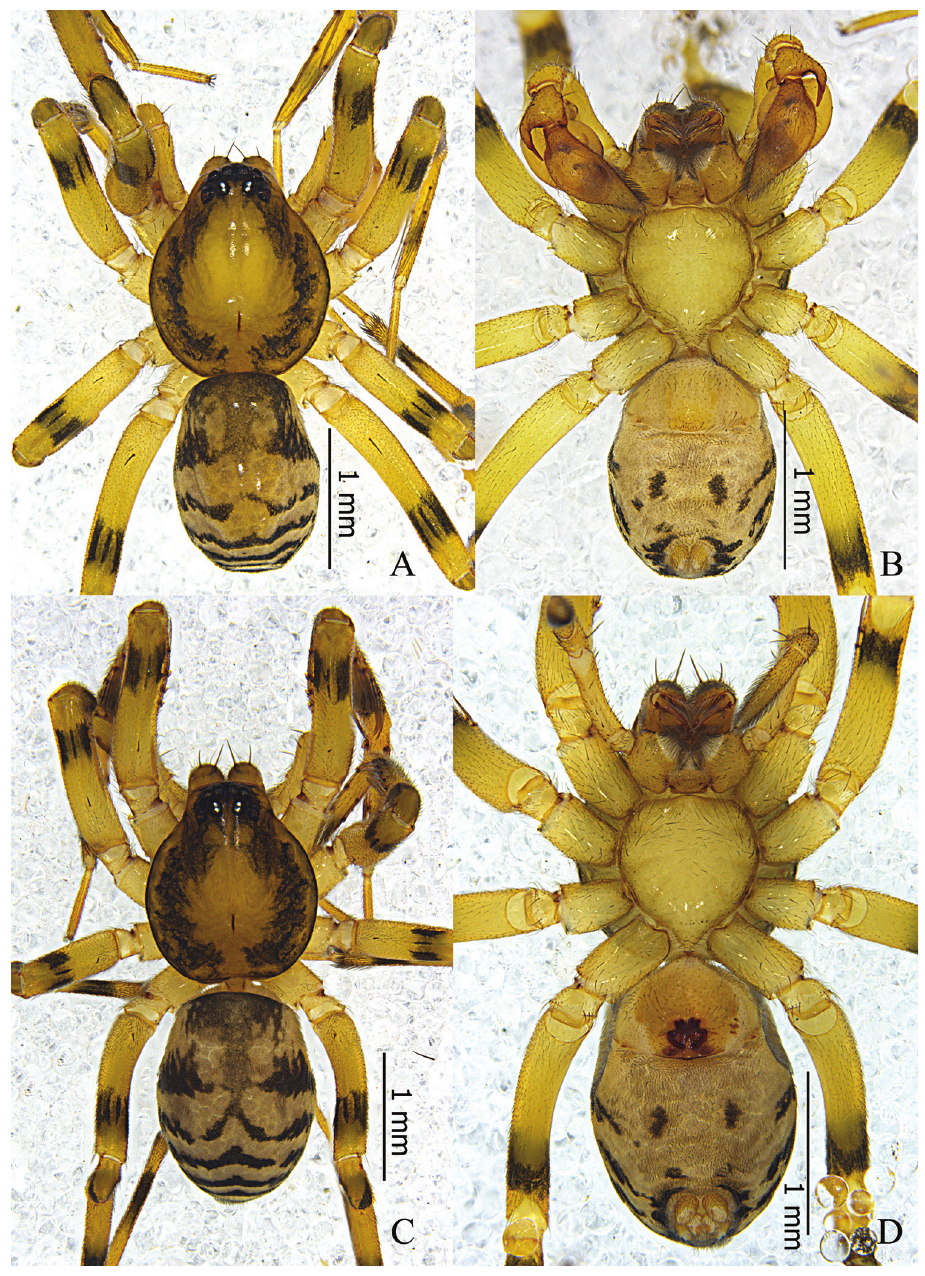
Figure 10. Otacilia submicrostoma sp. n. A male habitus, dorsal view B same, ventral view C female habitus, dorsal view D same, ventral